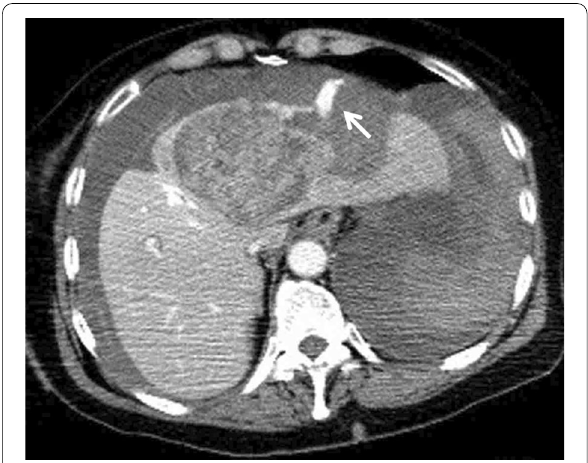
Fig. 1 Findings of CT on arrival at the hospital. Dynamic contrast-enhanced CT scan showing extravasation of contrast medium from the ruptured tumor in the medial segment of the liver and a large amount of high-density intra-abdominal fluid